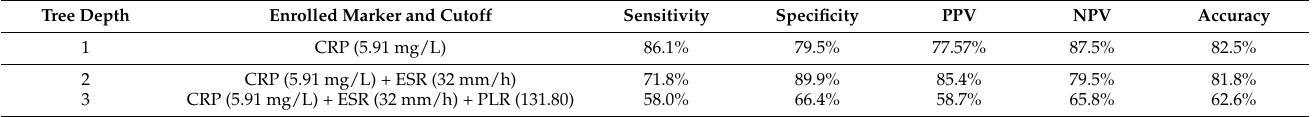
Table 4. Diagnostic performance of the tested biomarkers based on the classification tree. Tree